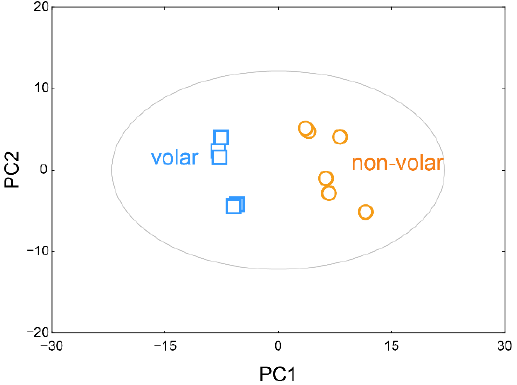
Figure 1. Principal component analysis (PCA) scores plot. PCA score plots based on GC/TOF-MS data show the relationship between volar and non-volar skin.